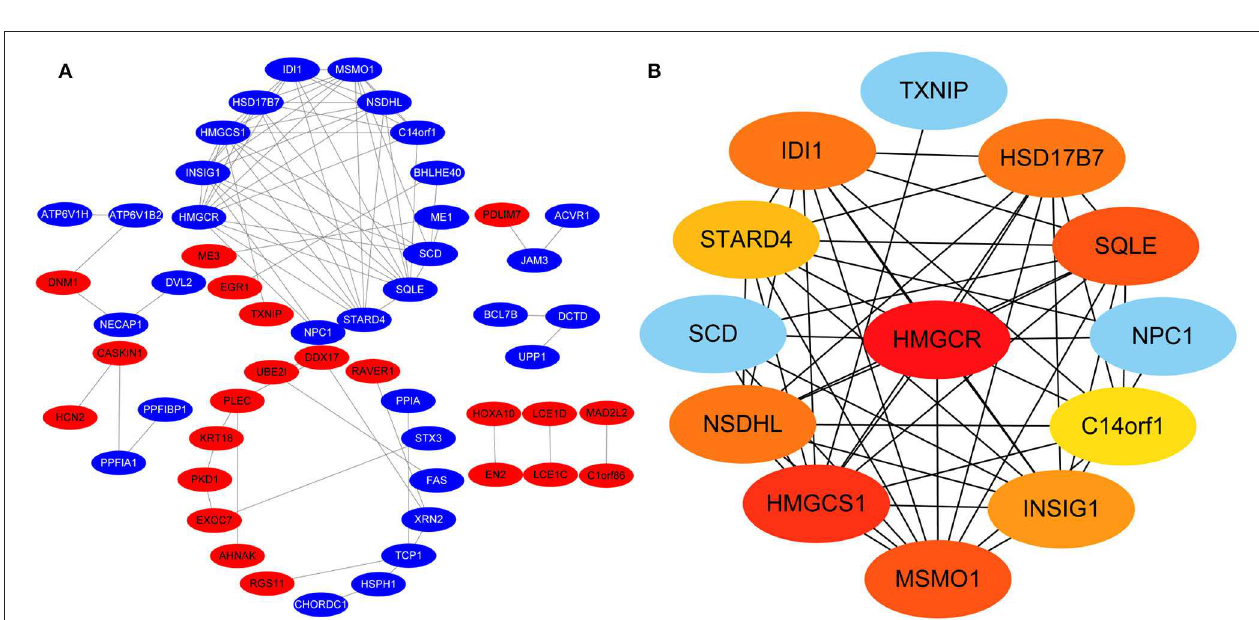
FIGURE 5 | PPI network at 5h. (A) Entire network. Downregulated and upregulated genes are represented by red and blue backgrounds, respectively. (B) Subnetwork for the top 10 hub genes and neighbors. The backgrounds of hub genes are colored from red to yellow by rank, and the backgrounds of neighboring genes are light blue. PPI, protein-protein interactions.